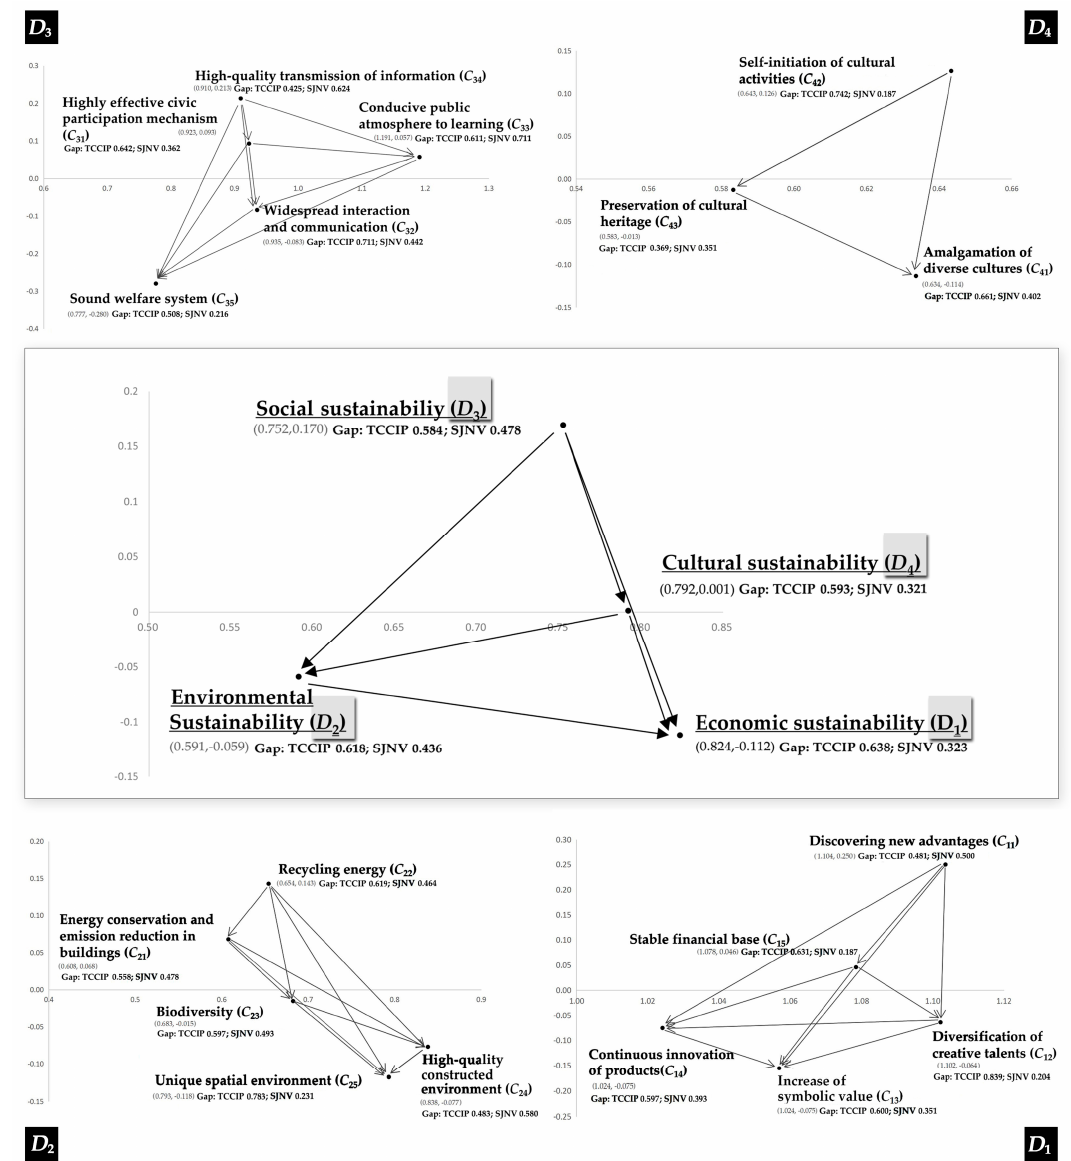
Figure 3. The INRM (influential network relation map) of total influence relationships.